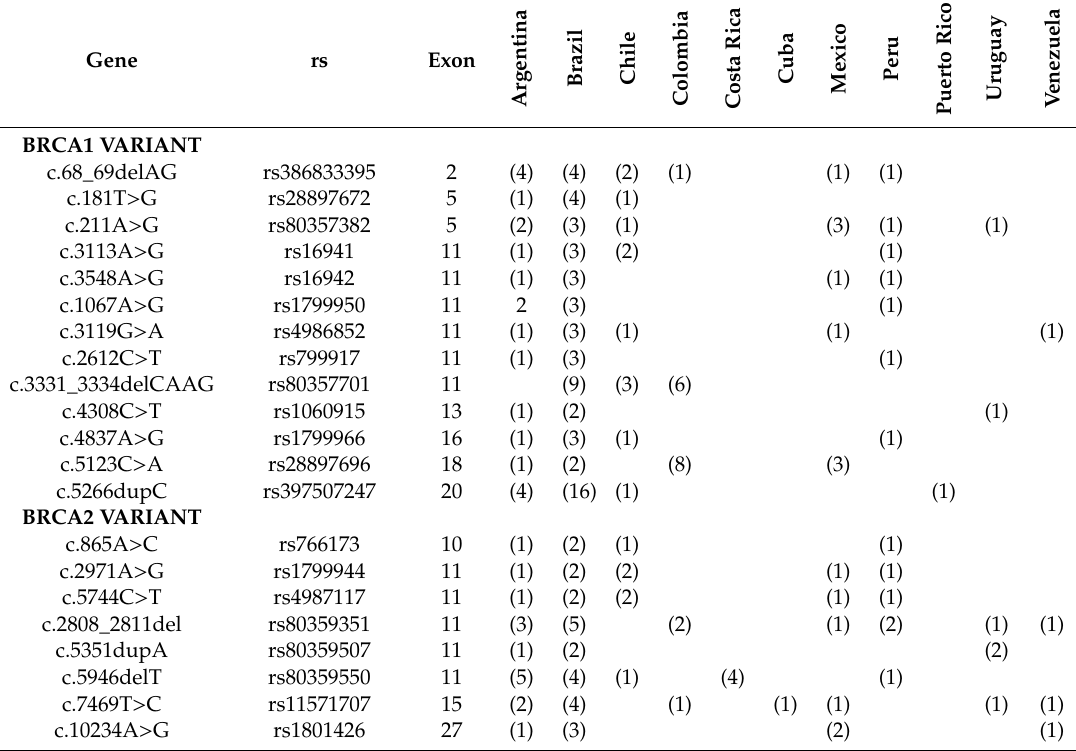
Table 3. Frequent BRCA1 / 2 gene variants in LA.